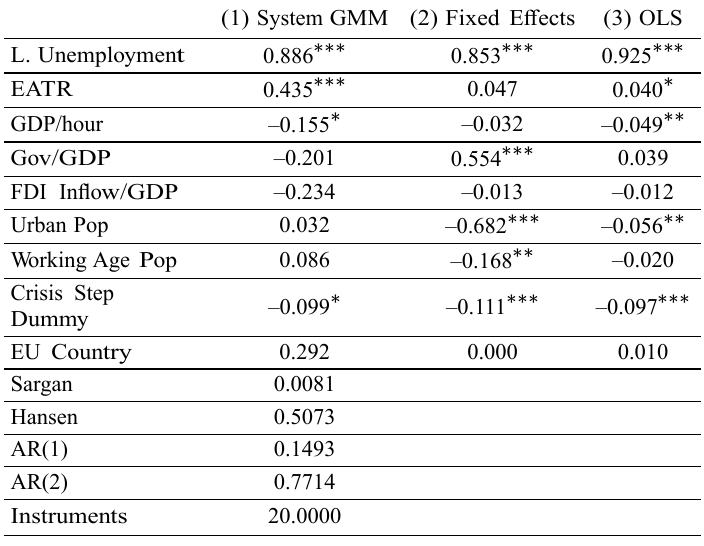
Table 2. Estimation results for corporate tax on